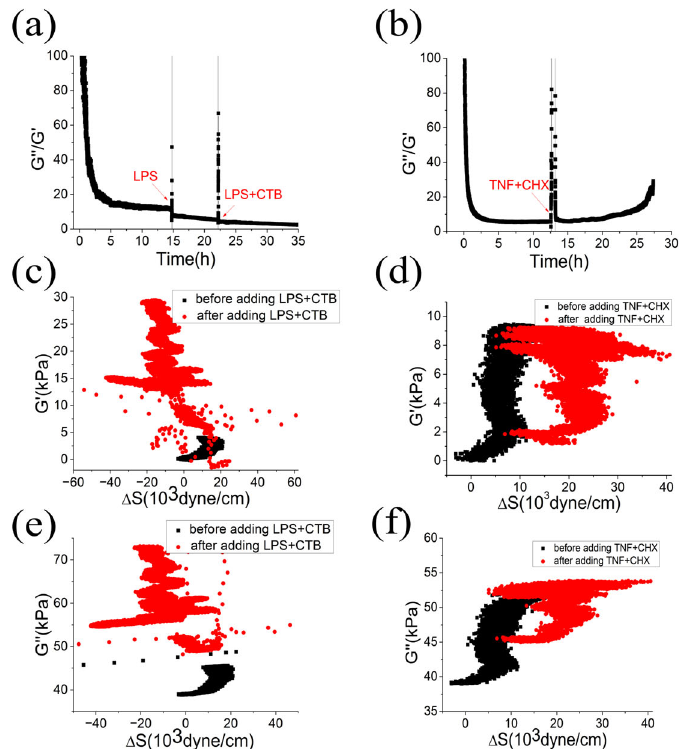
Figure 3. Changes in loss tangent and correlations between cytomechanical parameters during the LPS and CTB induced pyroptosis and TNF and CHX induced apoptosis in 2000 HeLa cells on FN modified quartz crystal-Au surfaces. ( a , b ) changes in loss tangent η = G (cid:48)(cid:48) / G (cid:48) ; ( c ) G (cid:48) versus ∆ S correlation during LPS+CTB stimulation; ( d ) G (cid:48) versus ∆ S correlation during TNF+CHX stimulation; ( e ) G (cid:48)(cid:48) versus ∆ S correlation during LPS+CTB stimulation; ( f ) G (cid:48)(cid:48) versus ∆ S correlation during TNF+CHX stimulation.